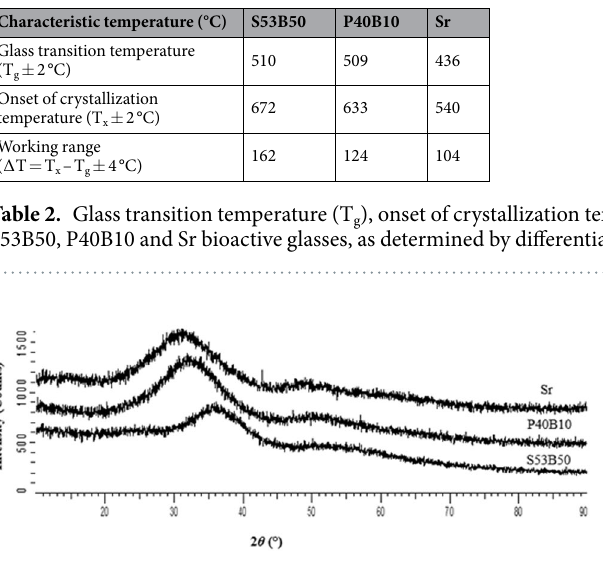
Figure 2. X-ray diffraction patterns of S53B50, P40B10 and Sr bioactive glasses after